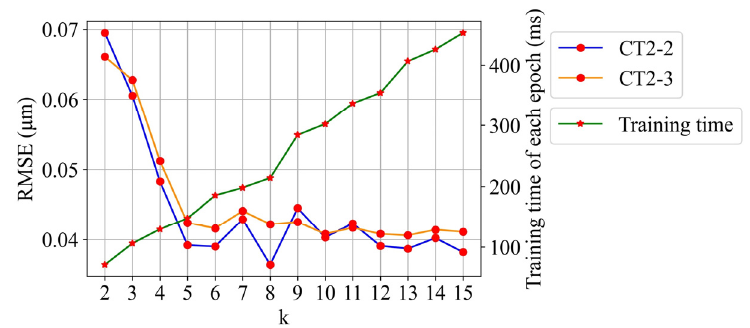
Figure 13. Effect of using different lengths of historical data ( k ) in the T1 task on prediction.